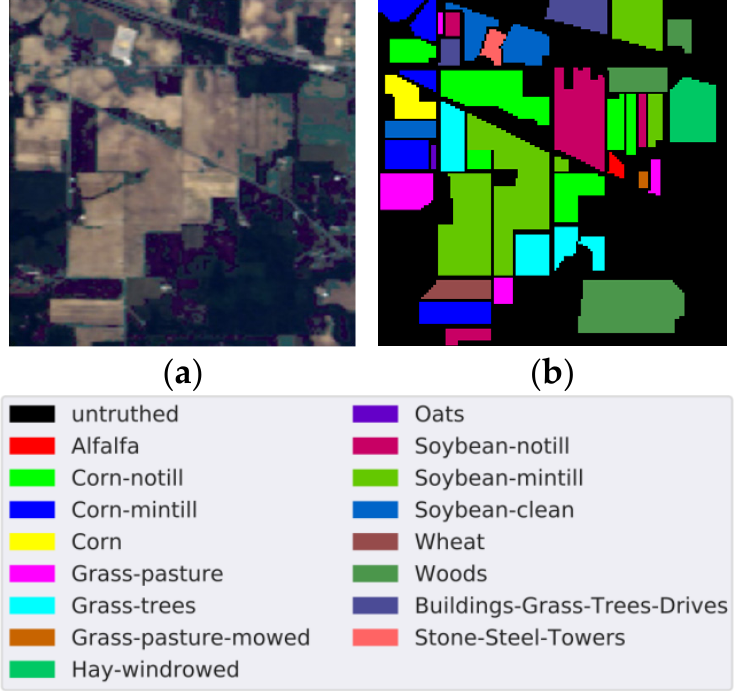
Figure 4. IP data set. ( a ) False-color image. ( b ) Ground-truth map. Table 1. Land cover classes and the numbers of samples in the IP data set.